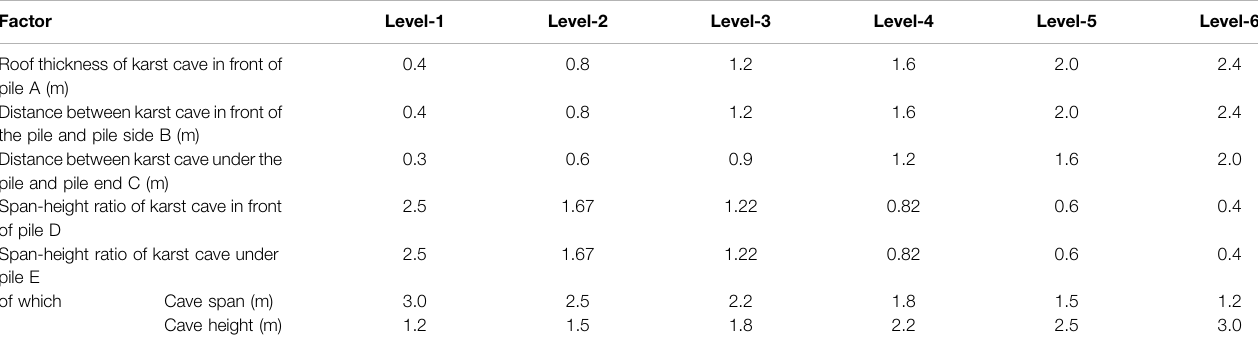
TABLE 3 | The level of each factor in the orthogonal test